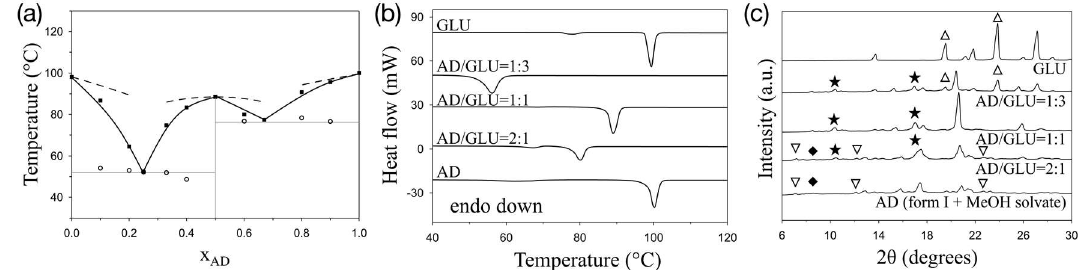
Figure 4. AD/GLU system: ( a ) melting diagram; ( b ) representative DSC thermograms; ( c ) representative XRD patterns. Top dashed lines in the melting diagram represent ideal liquidus lines. Some X-ray diffractions are marked as stars, triangles, inverse triangles, and diamonds for cocrystal, GLU, AD, and AD methanol solvate, respectively.